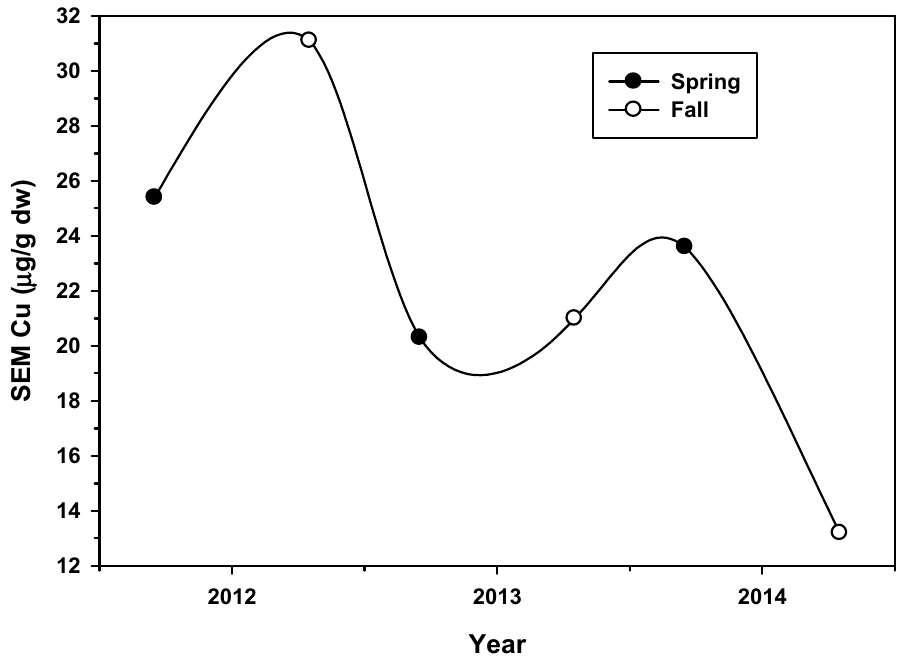
Figure 10. SEM copper concentrations (µg/g dry wt) from spring and fall sediment sampling at Cache Slough site CS-09 for the years 2012, 2013 and 2014.